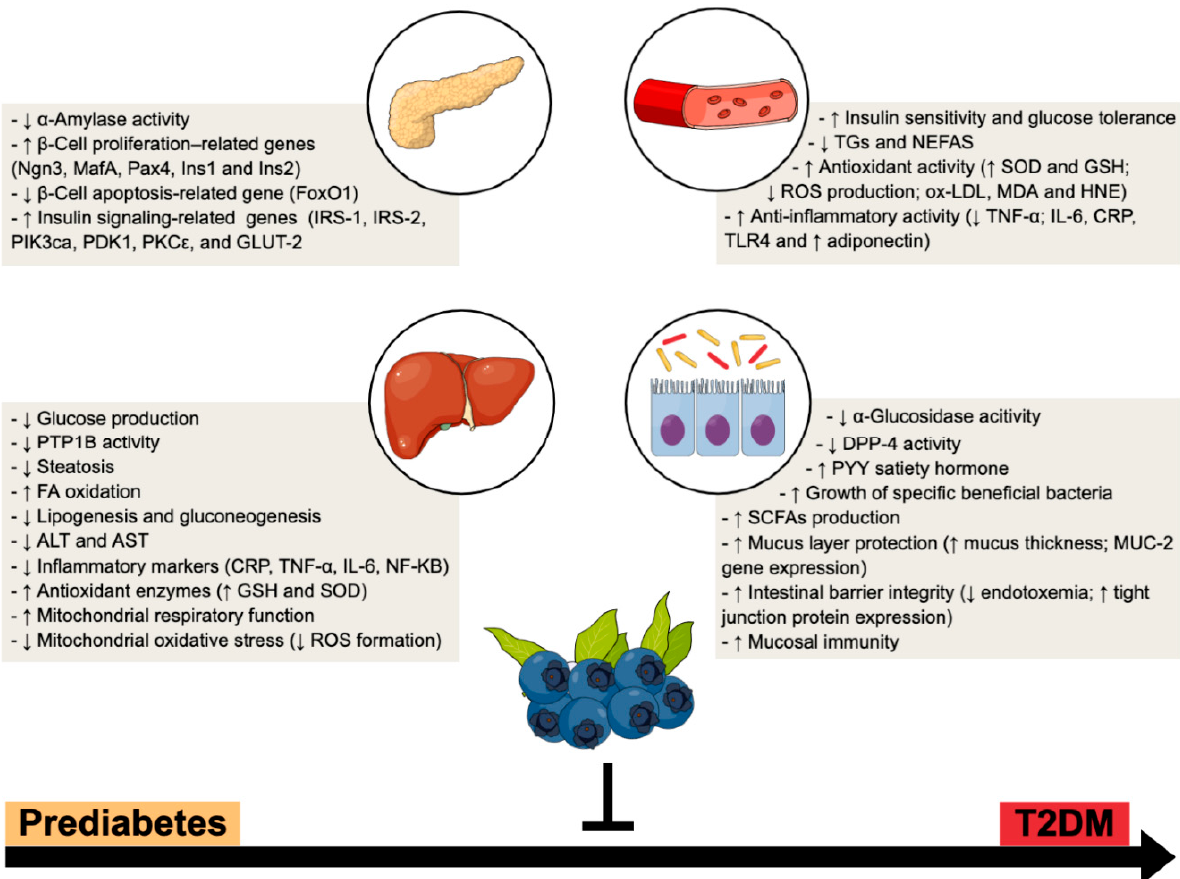
Figure 1. BB multi-organ impact within T2DM progression—a multi-modal functional fruit. Preclinical and clinical studies suggest a broad range of systemic and tissue (e.g., pancreas, liver and gut) beneficial mechanisms, which reinforces BB as an attractive nutraceutical to counteract the progression from prediabetes to overt T2DM. ↑ , increased; ↓ , decreased.